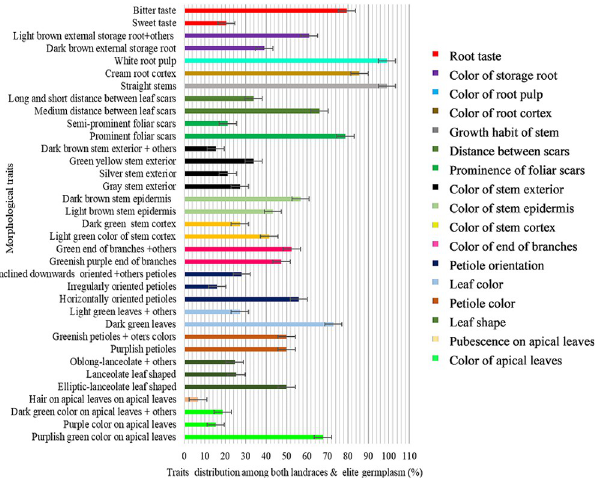
Fig 1. Morphological traits distribution among both landraces and elite germplasm with error bars indicating whether differences are statistically significant.